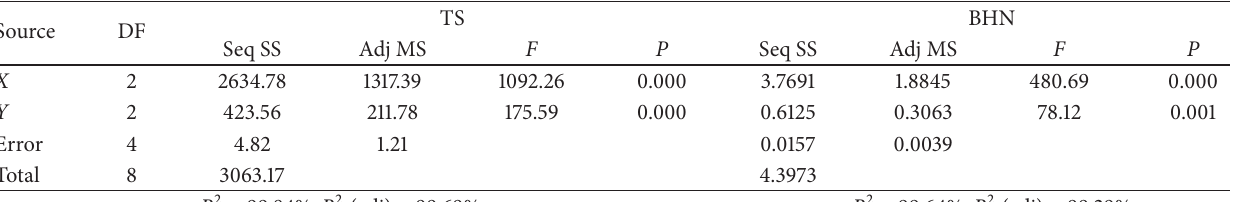
Table 7: Analysis of variance for TS & BHN of Al6061/Al 2 O 3 /MoS 2